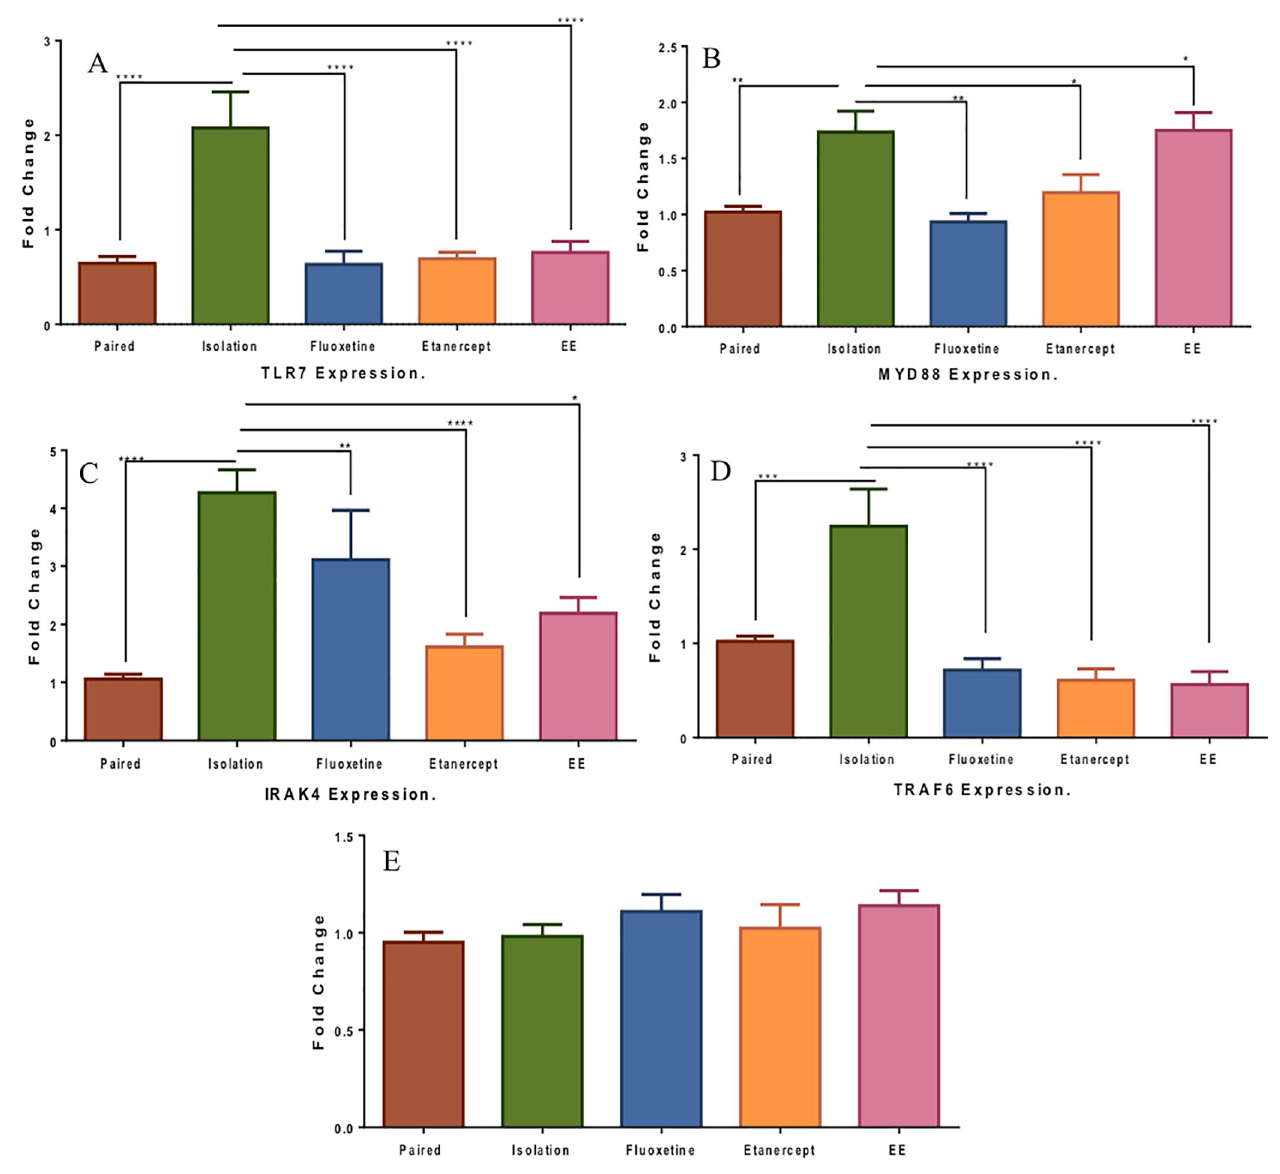
Fig 6. TLR7 and its signaling components mRNA expression in the hippocampus. The mRNA analysis of TLR7 and its signaling pathway in the experimental groups. The mRNA expression level for TLR7 pathway hippocampus brain region determined by RT-PCR analysis. (A) TLR7. (B) MYD88. (C) IRAK4. (D) TRAF6. (E) IRF5. Using GAPDH as an internal control. Data are expressed as fold change. Data normalized to the paired (control nondepressed group). The results are presented as the mean ± SEM from two independent experiments with triplicate (n = 3 animals per group). Data were analyzed using. One-way ANOVA followed by Tukey’s test. � P < 0.05; �� P < 0.01; ��� P < 0.001; ���� P <